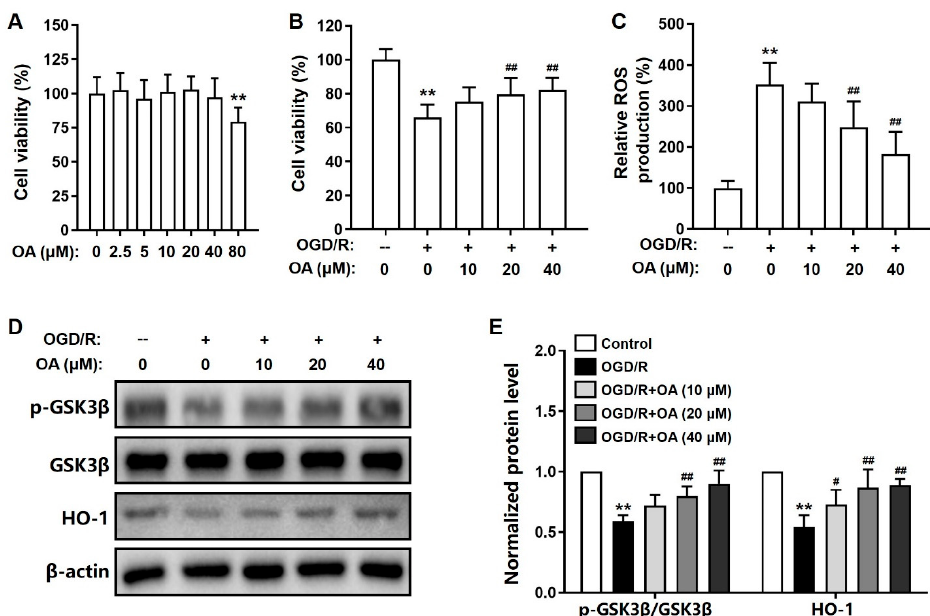
Figure 1. OA suppressed OGD/R-induced toxicity in SH-SY5Y cells via GSK-3 β /HO-1 pathway. ( A ) Cell viability of OA on SH-SY5Y cells. ( B ) Cell viability of OA and ( C ) relative ROS production on OGD/R-exposed SH-SY5Y cells with or without OA treatment. ( D ) Representative protein bands and ( E ) quantitative analysis of the p-GSK-3 β (Ser9)/GSK-3 β ratio and HO-1 protein expression levels in OGD/R-exposed SH-SY5Y cells with or without OA treatment. Data are shown as the mean ± standard deviation (S.D.). ** p < 0.01 versus the control group; # p < 0.05 and ## p < 0.01 versus the OGD/R group.